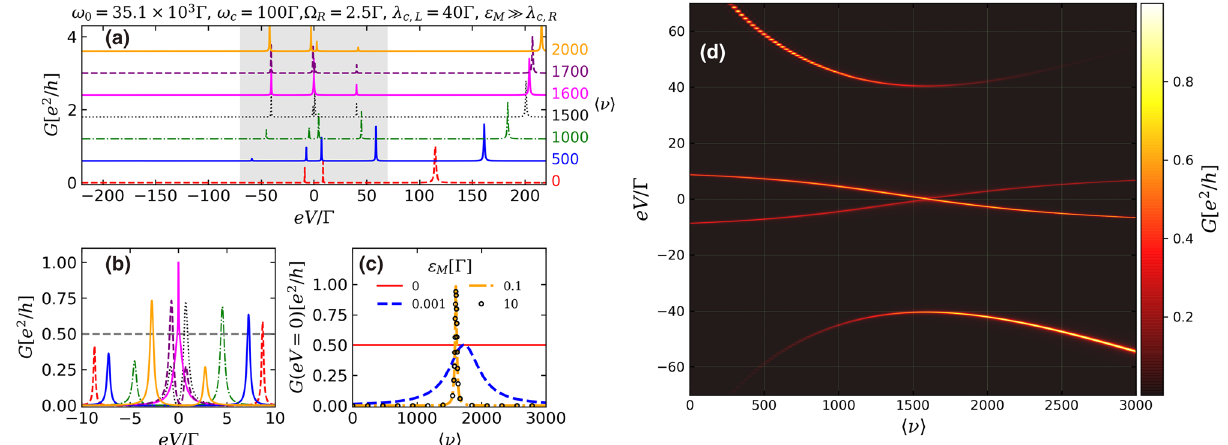
Figure 3. ( a ) Conductance through the QD [Eq. (6)] as a function of bias-voltage eV describing the case of 0 ) for increasing numbers of photon 10 Ŵ , (cid:31) c , R overlapped MZMs localized at the nanowire ends ( ε M = = ν occupation . For a better viewing, the curves are offset along the y axis. ( b ) Same curves depicted in ( a ), but (cid:31) (cid:30) considering eV only near zero-bias without offset along y axis. ( c ) Conductance through the QD at zero-bias 0 for increasing number of eV ν . ( d ) Colormap showing the conductance behavior as a function of both the = (cid:31) (cid:30) ν eV and , for a range of eV corresponding to gray region of ( a (cid:31) (cid:30) QD-nanowire coupling (Fig. 3a, dashed red line). As the mean photon occupation is increased, in analogy to what happened for nonoverlapped MZMs, the peak corresponding to the QD conduction level splits into two ν polariton peaks (Fig. 3a, solid blue line), with the value of this splitting depending on . It can be seen that (cid:31) (cid:30) the increase of the mean photon occupation strongly affects the pattern of near zero-energy peaks associated with overlapped MZMs (see Fig. 3b). First, they become closer to each other, and coalesce into a single peak 1600 . Further increase of the number of cavity photons leads to the ν at zero-bias with height of e 2 / h for � � = reappearance of the splitting. 0 as a function of the mean photon occupation is shown in Fig. 3c. One The conductance profile at eV = can notice that the zero-bias conductance plateau corresponding to nonverlapped and highly nonlocal MZMs (solid red line) is destroyed even by a small overlap (dashed blue line). For bigger values of the overlap strength 0 ) as a function of 1600 , showing the behavior similar to those ε M , G ( eV ν ν , exhibits a single peak at = (cid:31) (cid:30) � � = corresponding to a QD embedded in an optical cavity and decoupled from the nanowire (Fig. 2a, solid purple line). This similarity characterizes the single-fermion nature of the state formed from the overlap between the two half-fermionic MZMs. The conductance through the QD as a function of both eV and photon occupation, corresponding to the eV - range within the gray area in Fig. 3a, is shown in Fig. 3d. One can see that the photon-induced transitions in the QD renormalize its spectrum, giving rise to a ‘bowtie-like’ shape, which resembles those found by Prada et al. 32 . 1 ). This situation quali- In Fig. 4 we display the case in which the MZMs have lost their nonlocal feature ( η → tatively describes a scenario where the right MZM is displaced towards to left edge of the nanowire, leading to a partial separation between the MZMs and hence a finite overlap between the wavefunction of the right MZM ε M ) 31,32,36 . The emergence of this MZMs with partial separation can result from inhomo- and the QD ( (cid:31) c , R ≫ geneous confining potentials in the nanowire 22,23,25,31 . Similarly to Fig. 3a,b, we can notice two near-zero-energy (cid:31) conductance peaks at eV c , R for the case of zero photon occupation (Fig. 4a,b, dashed red line), which ≈ ± (cid:31) points that the left and right MZMs leak into the dot with different intensities ( (cid:31) c , L c , R ) and form a state of ≫ a regular fermionic character. 100 Ŵ is again splitted into two polariton peaks in The peak corresponding to the QD conduction level at eV ≈ presence of cavity photons, which also affects the position of the near-zero-energy conductance peaks (Fig. 4b). But distinct from the previous case of overlapped MZMs localized at the nanowire edges (Fig. 3b), there is no 0 for certain value of ν coalescence into a single peak at eV . = (cid:31) (cid:30) ν Figure 4c displays the evolution of zero-bias conductance as a function of for increasing values of coupling (cid:31) (cid:30) between the right-MZM and the QD. For the ideal situation of highly nonlocal MZMs (solid red line), one can see a ZBP plateau associated to the isolated MZM which has leaked into the dot. A plateau is still present for a 0 ) < 0.5 e 2 / h ). However, tiny value of (cid:31) c , R (dashed orange line), but with a reduction of the ZBP height ( G ( eV = a little enhancement of (cid:31) c , R (dotted green and dash-dotted blue lines) drops the zero-bias conductance to almost ν zero for any value of . (cid:31) (cid:30) ν The behavior of the conductance through the QD as a function of eV and photon occupation is shown in (cid:31) (cid:30) Fig. 4d. One can clearly notice that the near-zero-energy peaks corresponding to these MZMs with less degree of nonlocality slightly move away from each other as photon-induced peak (upper branch in Fig. 4d) is driven 0 and then start to approach each other again as the photon occupation is increased. This behavior towards eV = yields a pattern that resembles the ‘diamond-like’ profile reported by Prada et al. 32 . In this work, it was suggested,